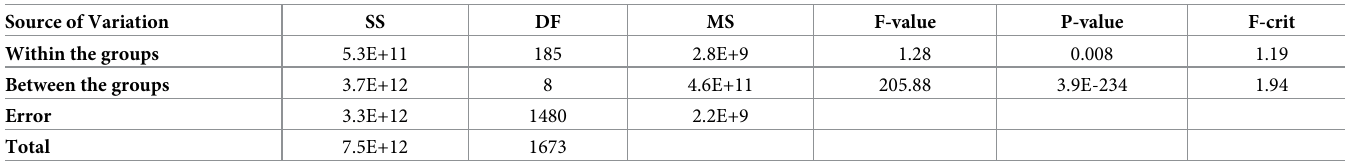
Table 6. ANOVA test results for the extracted features. Source of